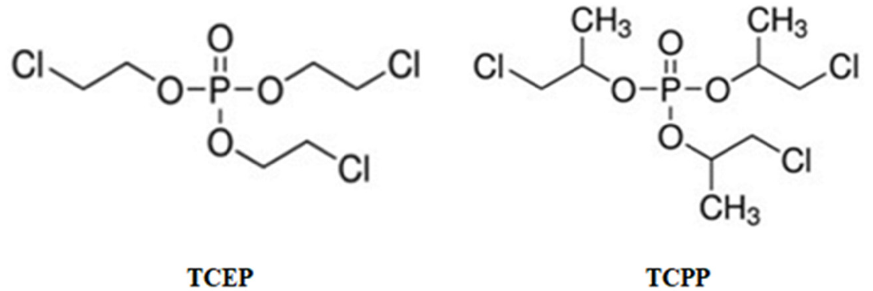
Figure 1. Chemical formulas of tris(2-chloroethyl) phosphate (TCEP) and tris(1-chloro-2-propyl) phosphate (TCPP).